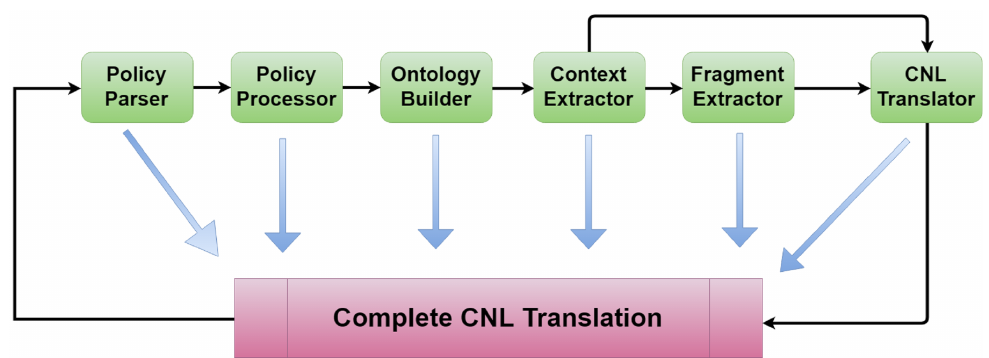
Figure 7. Complete Controlled Natural Language (CNL) translation